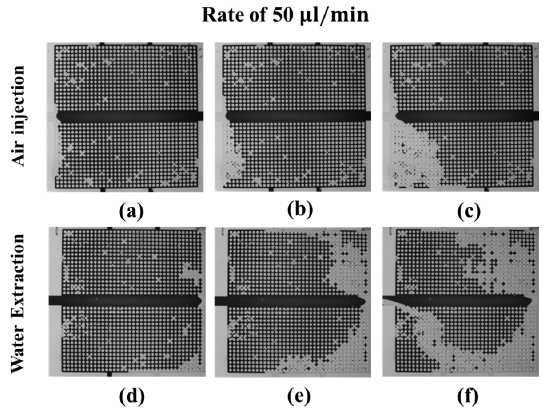
Figure 5. Dynamics of the water (dark)–air (transparent) distributions during the drainage process at an air-injection ( a – c ) and a water-extraction ( d – f ) rate of 50 μ L/min; ( a , d ) correspond to the beginning, ( b , e ) to the middle, and ( c , f ) to the end of the drainage process.